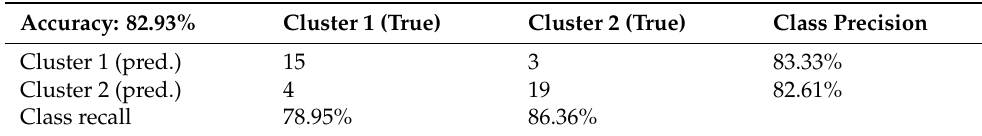
Table 4. Confusion matrix for prediction performance of unseen